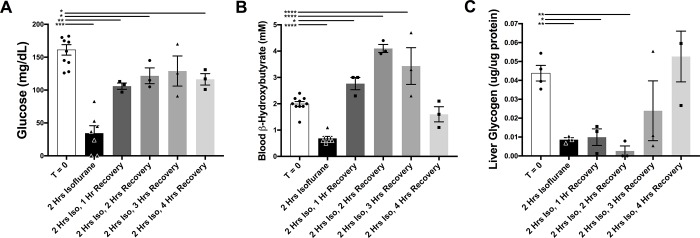
Metabolic recovery timeframe in P7 neonates anesthetized for 2 hours.(A) P7 mouse blood glucose concentration at baseline, at 2 hours of anesthesia with 1.5% isoflurane, and at 1 to 4 hours of recovery from 2 hours of anesthesia (baseline and 1-hour timepoints also in Fig 1). ANOVA p-value<0.0001; *p<0.05, **p<0.005, ***p<0.0005 by post-hoc pair-wise t-tests. n = 10, 7, 3, 3, 3, and 3 for baseline, 2 hours exposure, and 1, 2, 3, and 4 hours post-exposure, respectively. (B) P7 mouse blood ß-hydroxybutyrate concentration at baseline, at 2 hours of anesthesia with 1.5% isoflurane, and at 1 to 4 hours of recovery from 2 hours of anesthesia. ANOVA p-value<0.0001; *p<0.05, ****p<0.0001 in post-hoc pair-wise t-tests. n = 10, 7, 3, 3, 3, and 3 for baseline, 2 hours exposure, and 1, 2, 3, and 4 hours post-exposure, respectively. (C) Liver glycogen concentration at baseline, at 2 hours of anesthesia with 1.5% isoflurane, and at 1 to 4 hours of recovery from 2 hours of anesthesia. ANOVA p-value<0.0001; *p<0.05, **p<0.005, ***p<0.0005 in post-hoc pair-wise t-tests. n = 4, 3, 3, 3, 3, and 3 for baseline, 2 hours exposure, and 1, 2, 3, and 4 hours post-exposure, respectively. Each data-point represents an individual animal; error bars depict SEM. Baseline and 1-hour timepoints in (A) and (B) also in Fig 1.